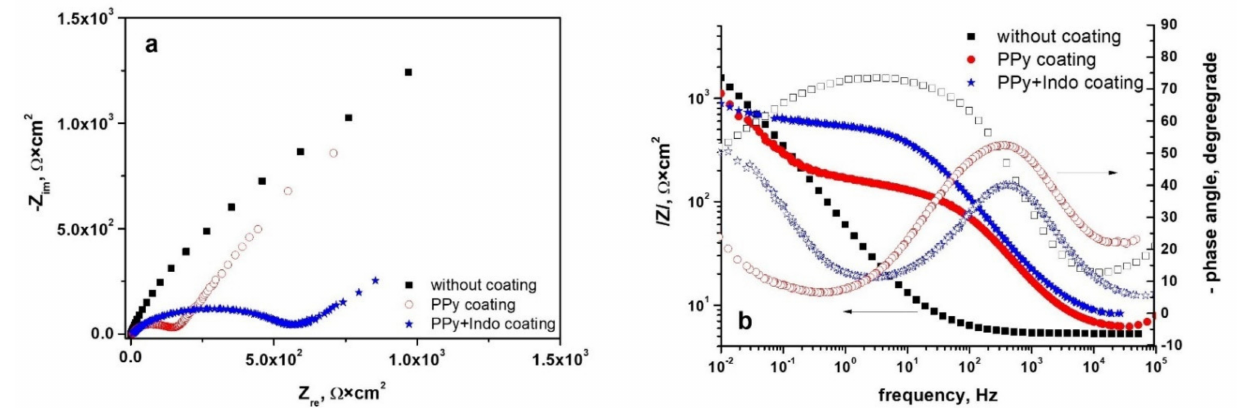
Figure 8. Nyquist ( a ) and Bode ( b ) diagrams for uncoated and PPy or PPy-Indo coated Hera type CoCr based alloys in Tani-Zuchi artificial